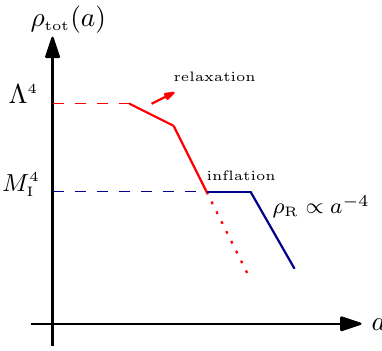
Figure 35 . Sketch of the energy density of the universe as a function of the scale factor when relaxation happens before in(cid:13)ation and ends because of axion fragmentation.